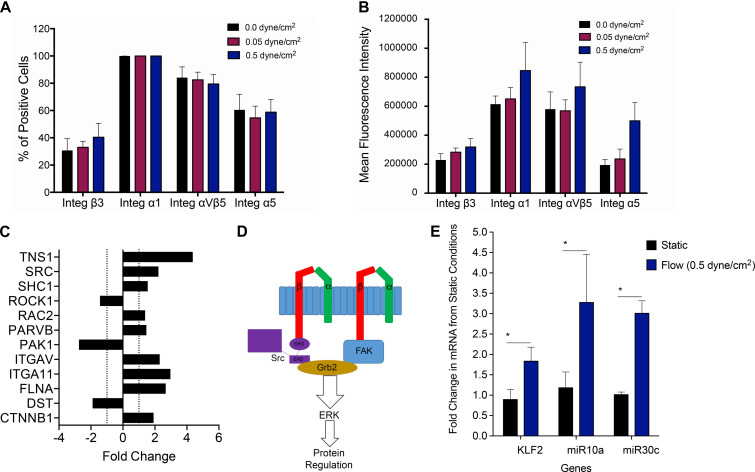
Investigating molecular pathways involved in mechanotransduction in PLC-mcoET3. (A) Flow cytometric analysis of integrins which have previously been reported to be affected by shear stress (n = 4 for each integrin). Shear stress did not affect the percentage of cells positive for any of the integrins studied. (B) Mean fluorescent intensity (MFI) obtained by dividing each integrin MFI by the respective isotype’s MFI (n = 4) was also used to investigate differences in cell surface integrin expression. No statistically significant differences were found between cells in static conditions and the cells under fluidic shear stress. (C) PCR array-based pathway-focused gene expression analysis on RNA isolated from the PLC-mcoET3 cultured under static conditions (n = 3) and conditions of shear stress (0.5 dyne/cm2) to examine possible shear-responsive pathways affected by shear stress (n = 3) demonstrating upregulation (+fold change) or downregulation (- fold change) of several genes related to shear-sensing pathways. (D) Mechanotransduction of the SRC pathway and FAK through beta integrins initiates the ERK pathway as a possible mechanism for the flow regulation of PLC-mcoET3. (E) RT-qPCR to quantify KLF2 (n = 6), miR10a (n = 4), and miR30c (n = 3) under static and flow conditions demonstrated that KFL2, miR10a, and miR30c are significantly increased under flow (p < 0.05). *corresponds to p < 0.05.